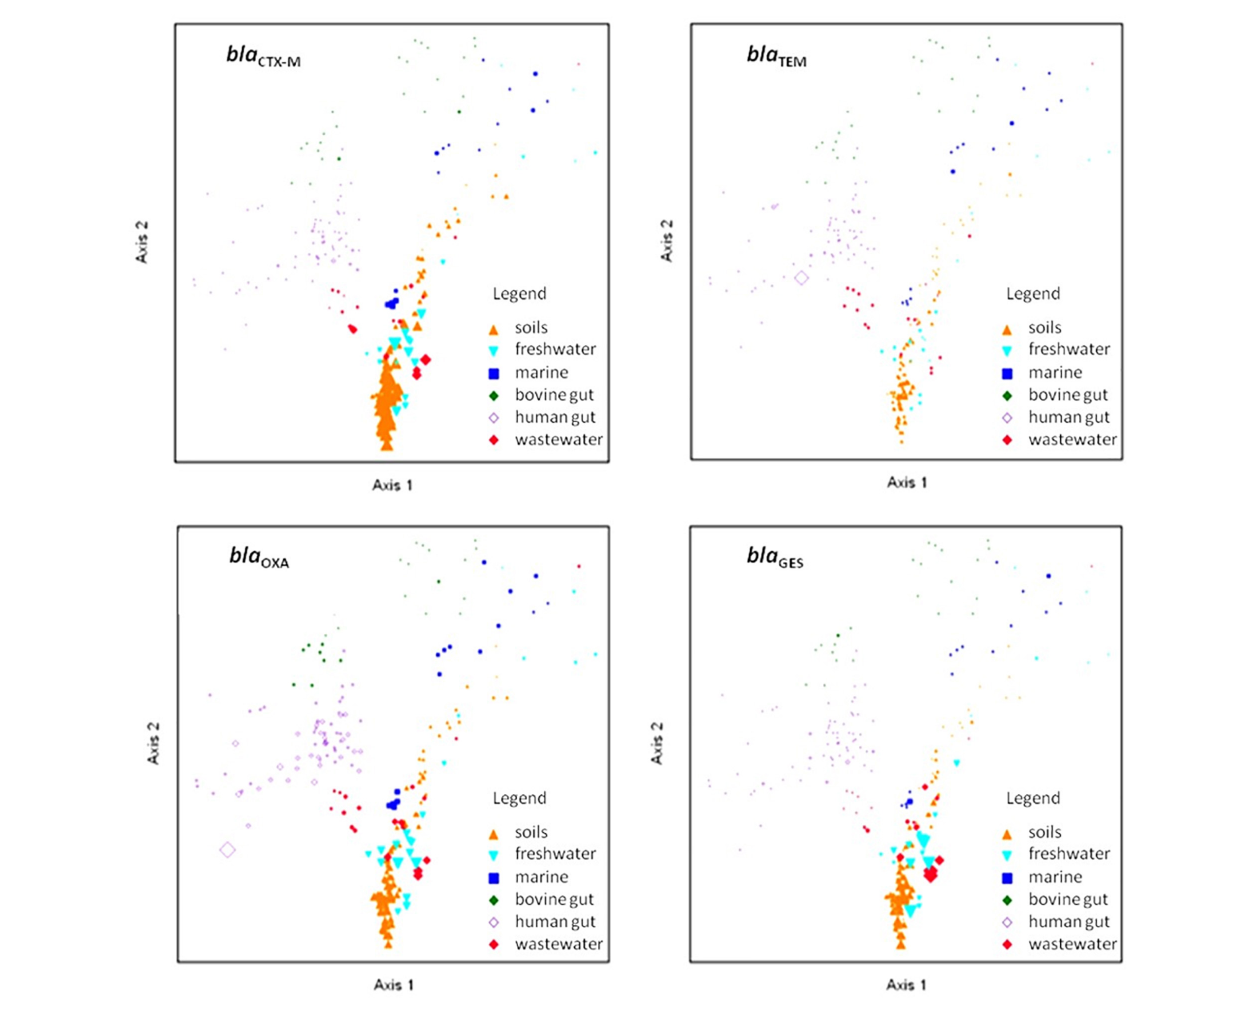
FIGURE 5 | Non-metric multidimensional scaling ordination of selected β -lactamase gene homologs. Shapes and colors represent the environmental source of the metagenome samples. The point sizes are proportional to the abundance of the depicted gene. The PC-ORD generated stress was between 15.2 and 15.5, depending on the number of iterations and dimensions